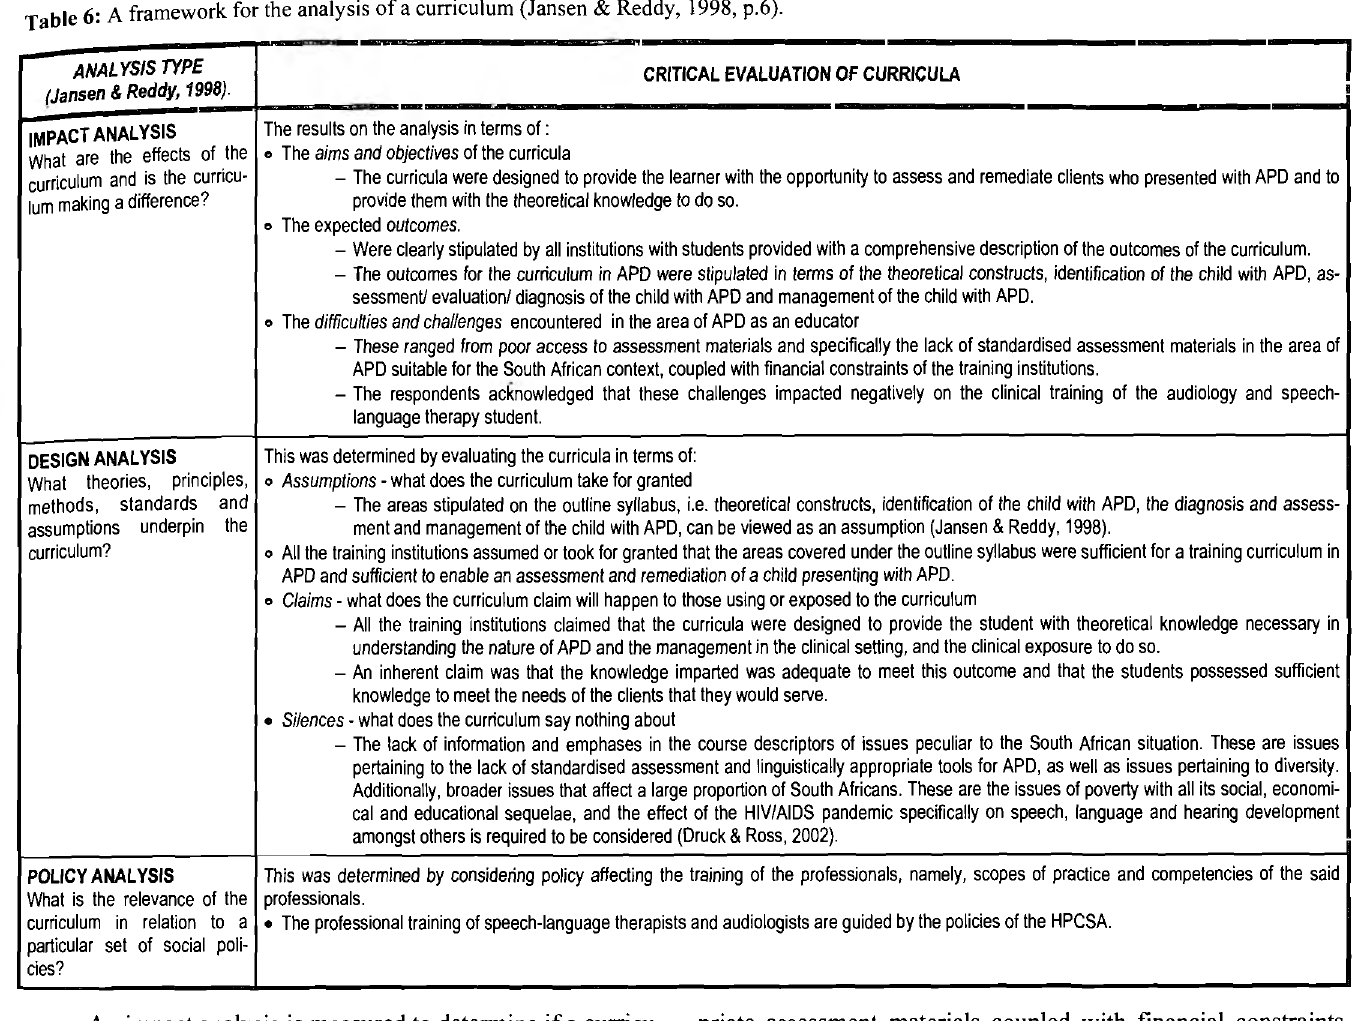
Table 6: A framework for the analysis of a curriculum (Jansen & Reddy, 1998, p.6). analysis type (Jansen & Reddy,